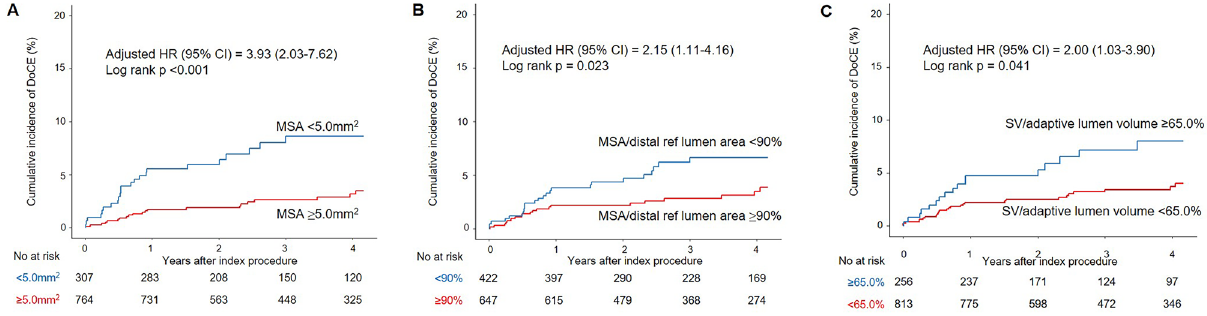
Table 5. The risk of DoCE according to OCT-defined stent expansion criteria. Patient-level analysis was performed. Adjusted covariates include age, male sex, hypertension, diabetes, current smoker, chronic kidney disease, myocardial infarction, dual antiplatelet use at discharge, statin use at discharge, total stent length, mean stent diameter, and adjuvant ballooning. CI confidence interval, DoCE device-oriented clinical end point, HR hazard ratio, MSA minimal stent area, OCT optical coherence tomography, SV stent volume.